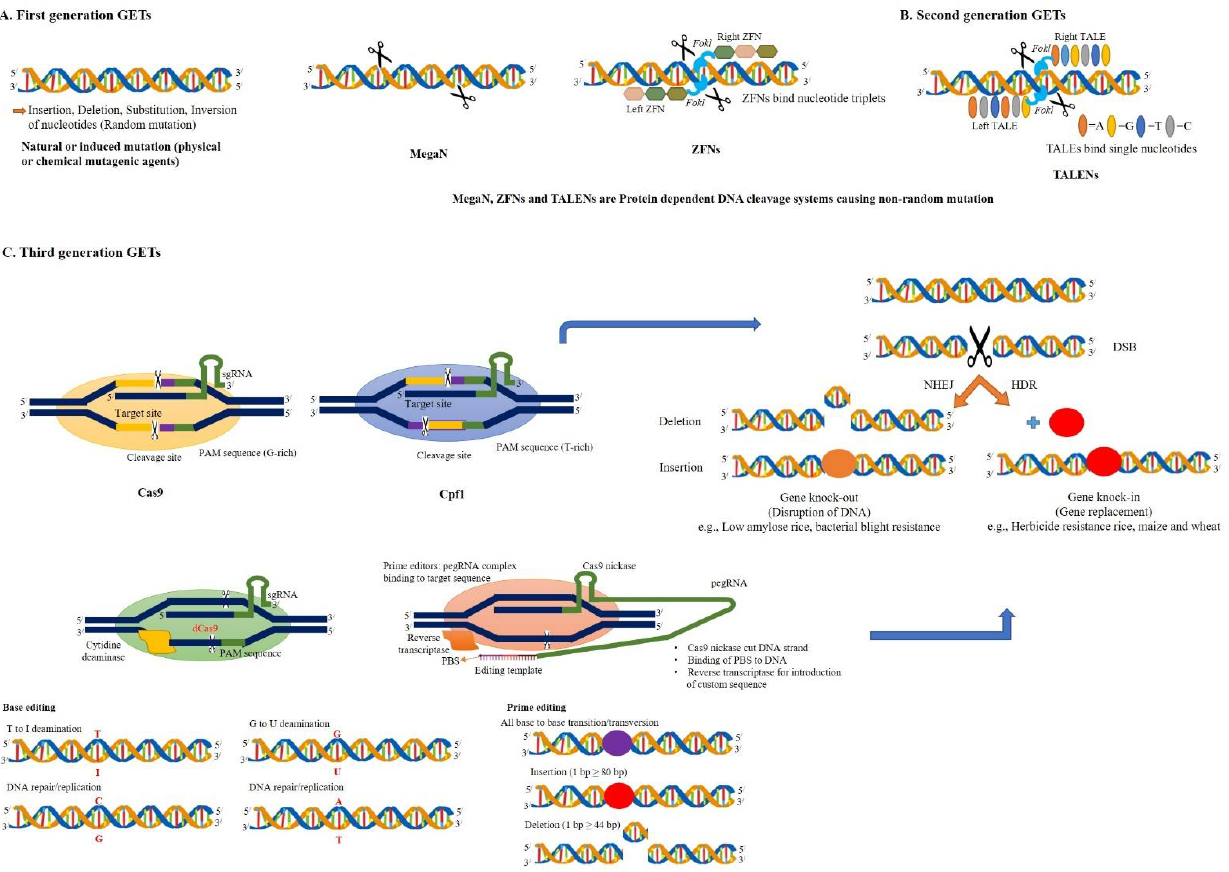
Figure 2. Schematic models of gene editing systems. ( A ) The first generation included induced mutation through mutagenic agents, Radiations and EMS (Ethyl methanesulfonate), meganuclease (MegaN), and Zinc finger nucleases (ZFNs); ( B ) second generation included transcription activator-like effector nucleases (TALENs); ( C ) third generation included the CRISPR-associated protein system 9 (Cas9), the CRISPR system from Prevotella and Francisella1 (Cpf1), BE and PEs. The GETs from MegaN, ZFNs, TALENs, CRISPR/Cas9, Cpf1 generate DSBs. BE and PE create mutations without DSBs. DSB = double-stranded breaks; dCas = catalytically inactive (dead) Cas; PAM = protospacer adjacent motif; PBS = primer binding site; NHEJ = non-homology end joining; HDR = homology-directed repair.